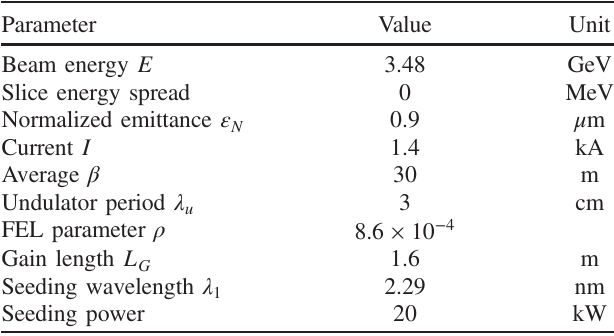
TABLE I. Simulation parameters in 1D FEL code.